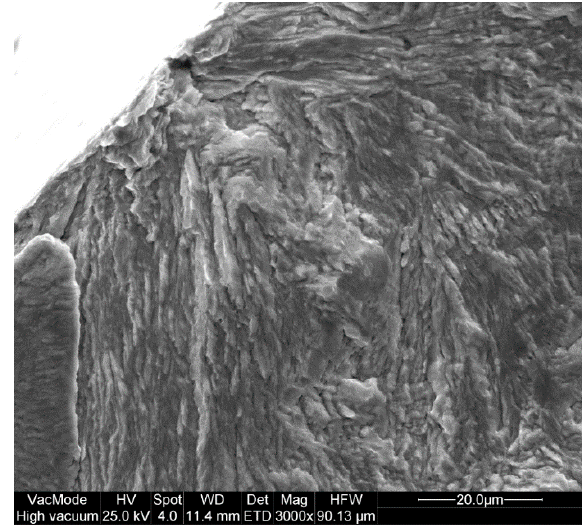
Figure 7. Surface crack initiation of the large specimen ( σ a = 510 MPa, N f = 1.06 × 10 8 ).